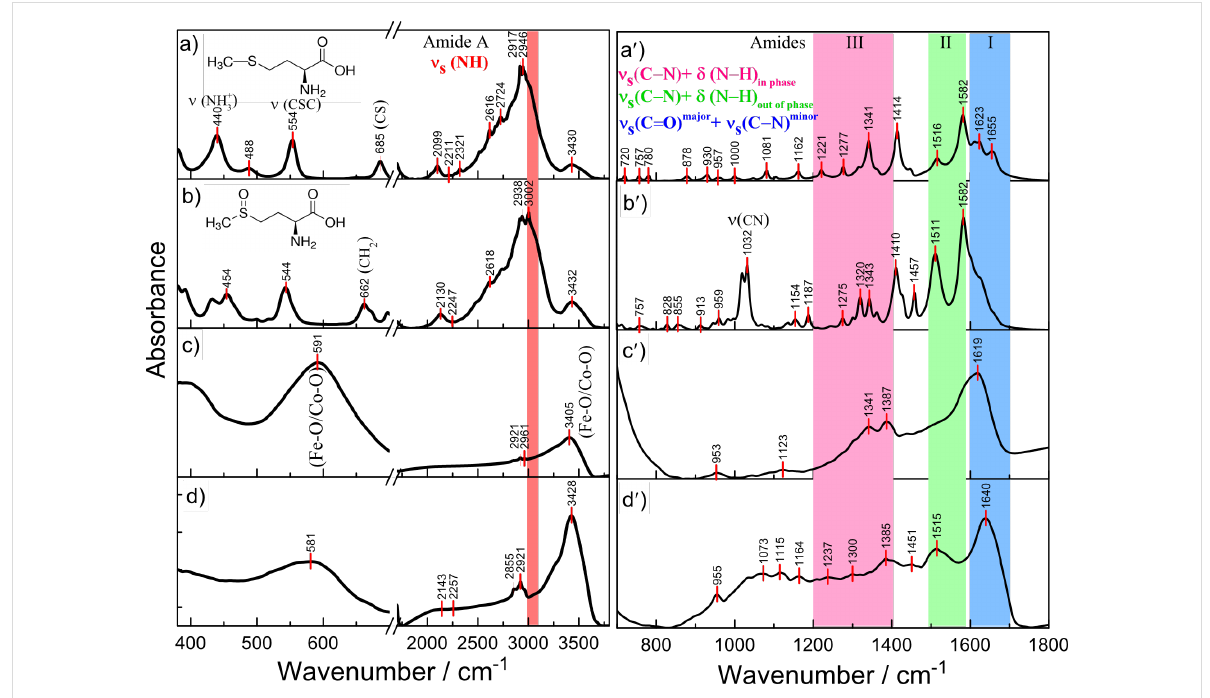
Figure 6: FTIR spectra of methionine (a, a ′ ), methionine sulfoxide (b, b ′ ), cobalt ferrite NPs stabilized with methionine (c, c ′ ), and the same NPs after decoration with gold (d, d ′ ) within the indicated wavenumbers.